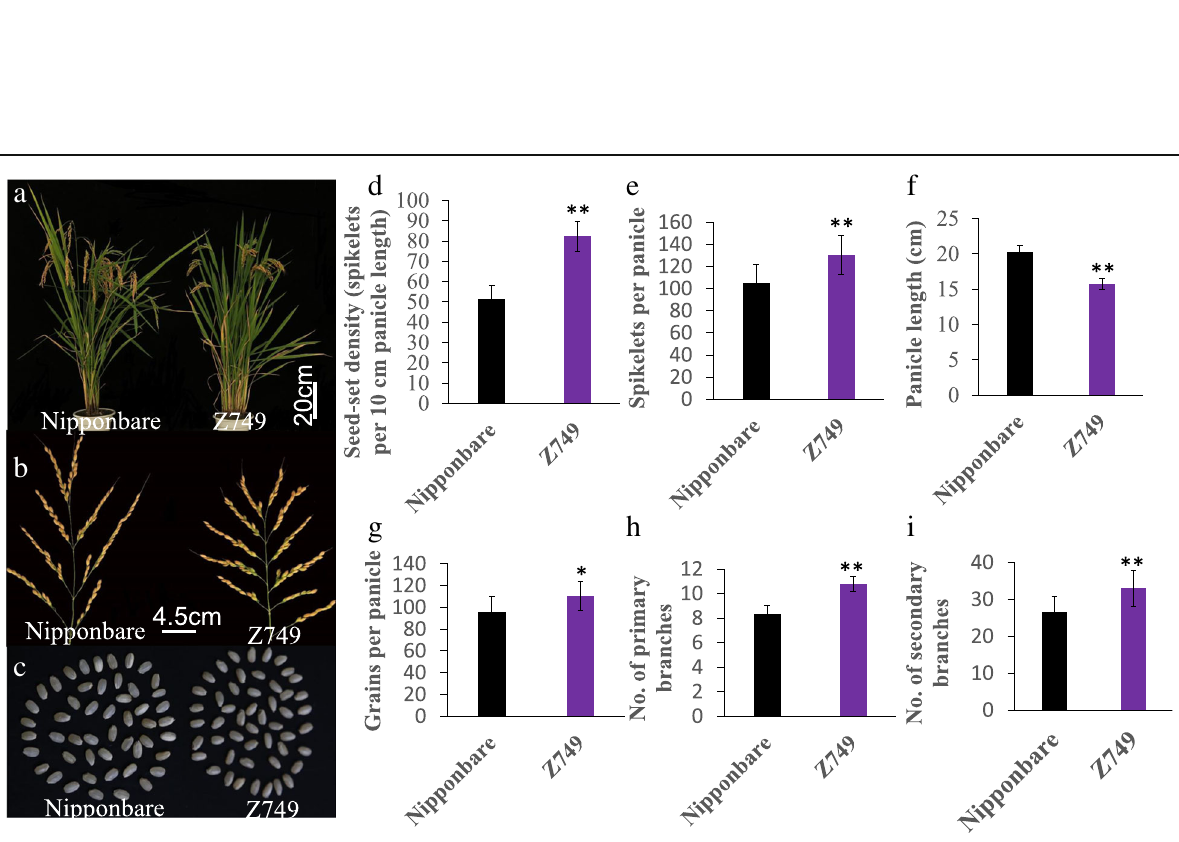
Fig. 2 Phenotype of Nipponbare and Z749. a Plant type of Nipponbare and Z749. b Panicle of Nipponbare and Z749. c Brown rice of Nipponbare and Z749. d Seed-set density. e Spikelet number per panicle. f Panicle length. g Grain number per panicle. h Number of primary branches. i Number of secondary